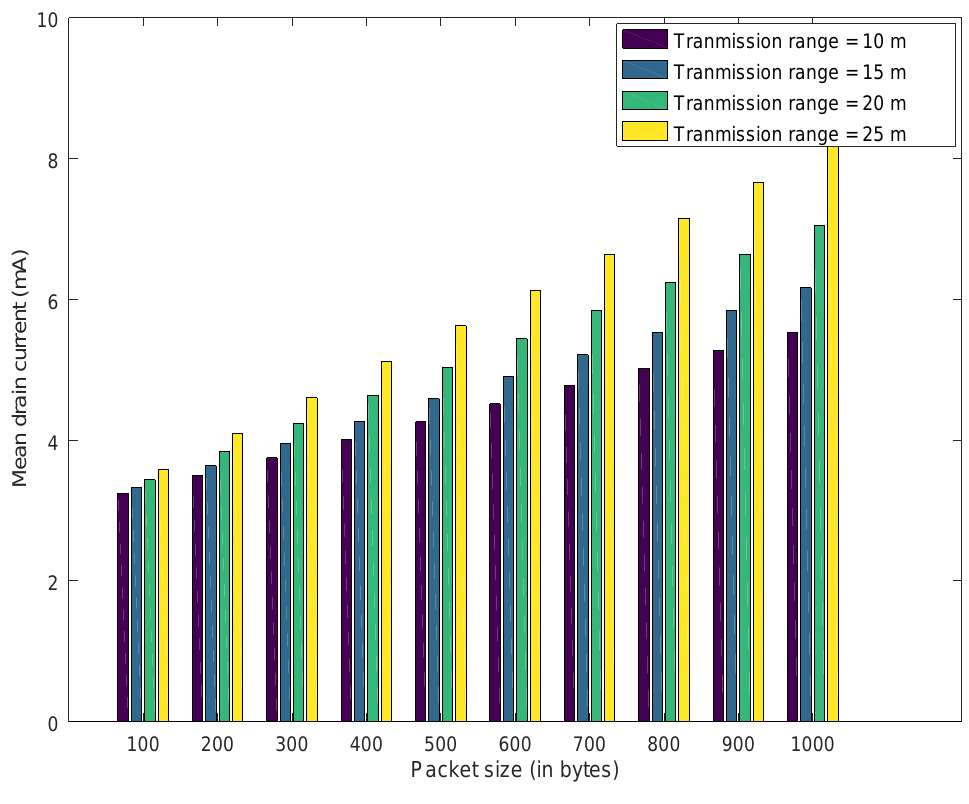
Figure 17. Required Current for the device—Best Case.